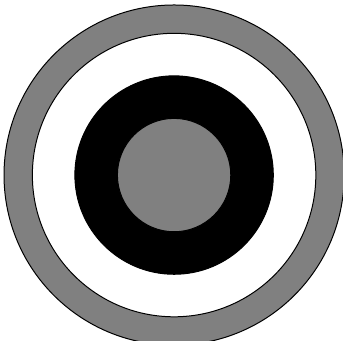
Figure 13 . Phase space density corresponding to a superstar made of N c giant gravitons, followed by N 2 fermions with N c excitations and a second superstar made of N 0 of energy M